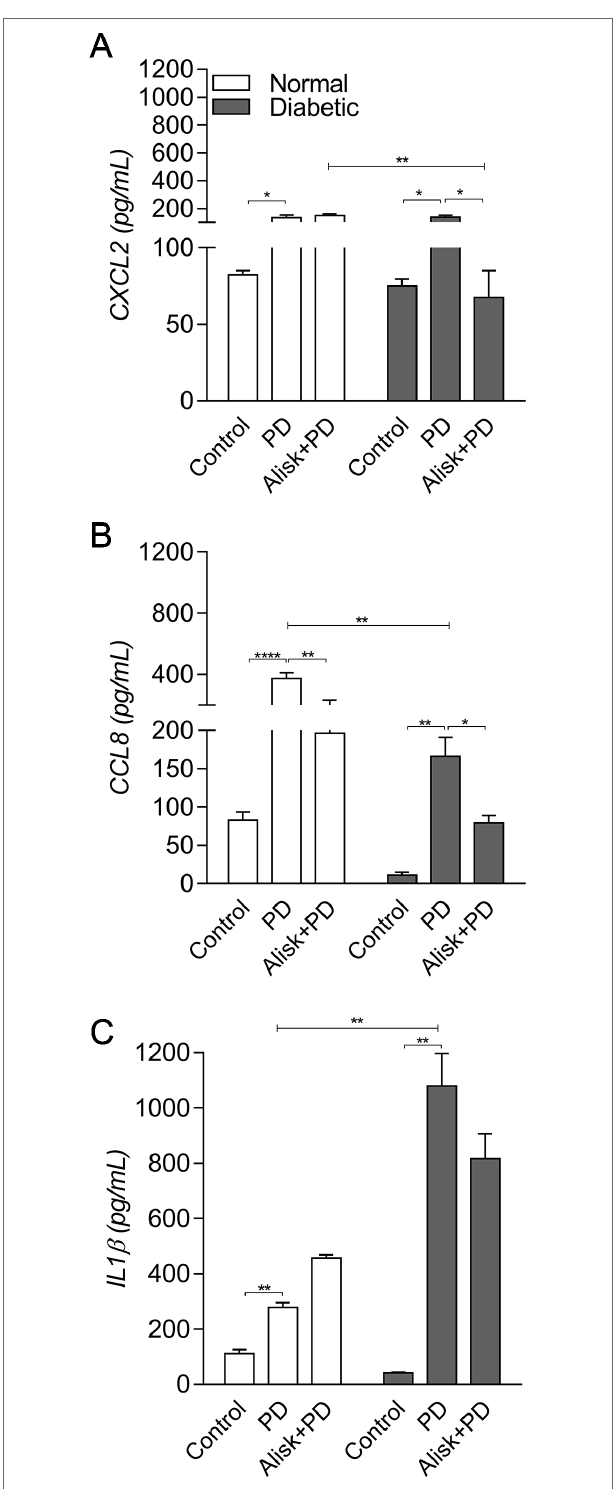
FIGURE 2 | Production of CXCL2, CCL8, and IL-1 β by gingival tissue from normal and diabetic mice 14 days after PD. (A) CXCL2, (B) CCL8, and (C) IL1 β by ELISA. Data represented as mean ± SEM (n = 10). Statistical differences represented by *p < 0.05, **p < 0.01, and ****p < 0.0001 (Control vs. PD; PD vs. Alisk + PD; and PD vs.